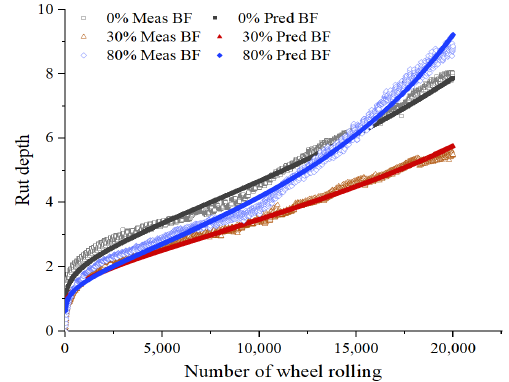
Figure 17. HWTT curve of BF asphalt mixture.